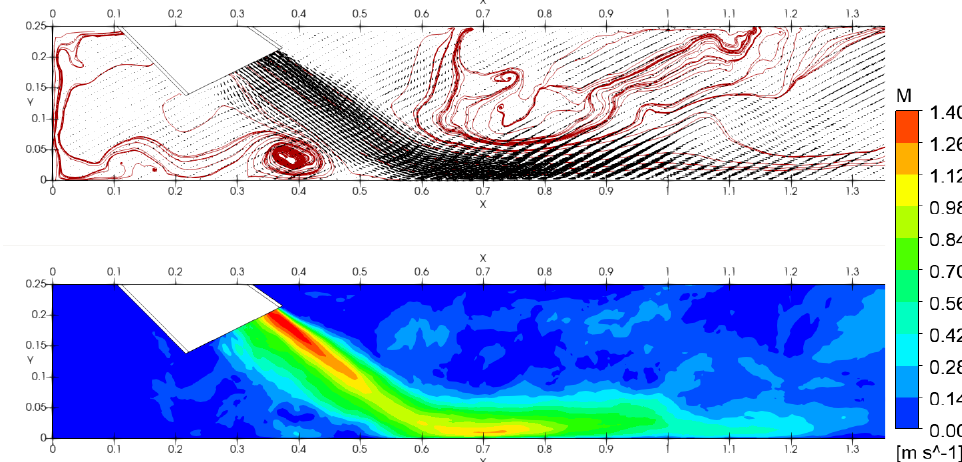
Figure 12. LBM, vector lines ( top ) and the magnitude of time-averaged 2D velocity ( bottom ) in vertical plane ( z = 75mm ) .